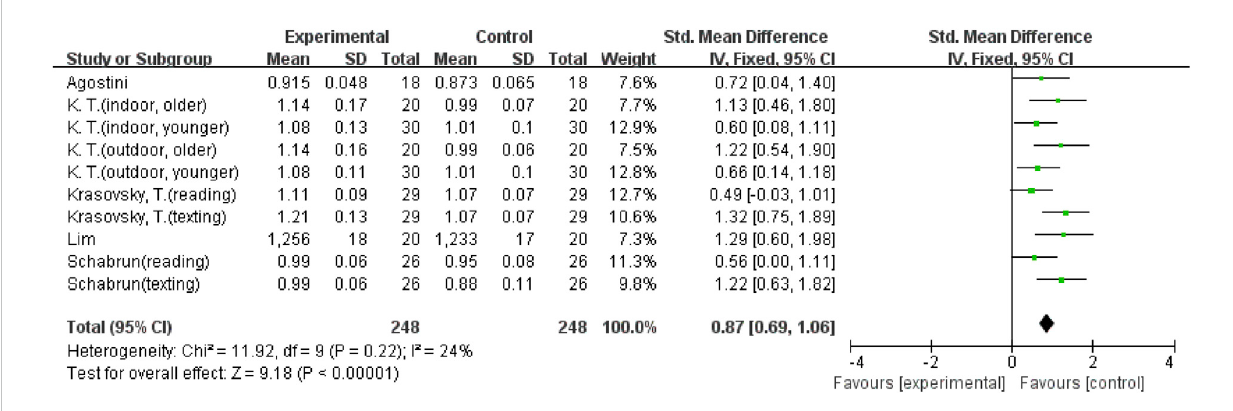
FIGURE 7 The effect of mobile phone use on stride time.